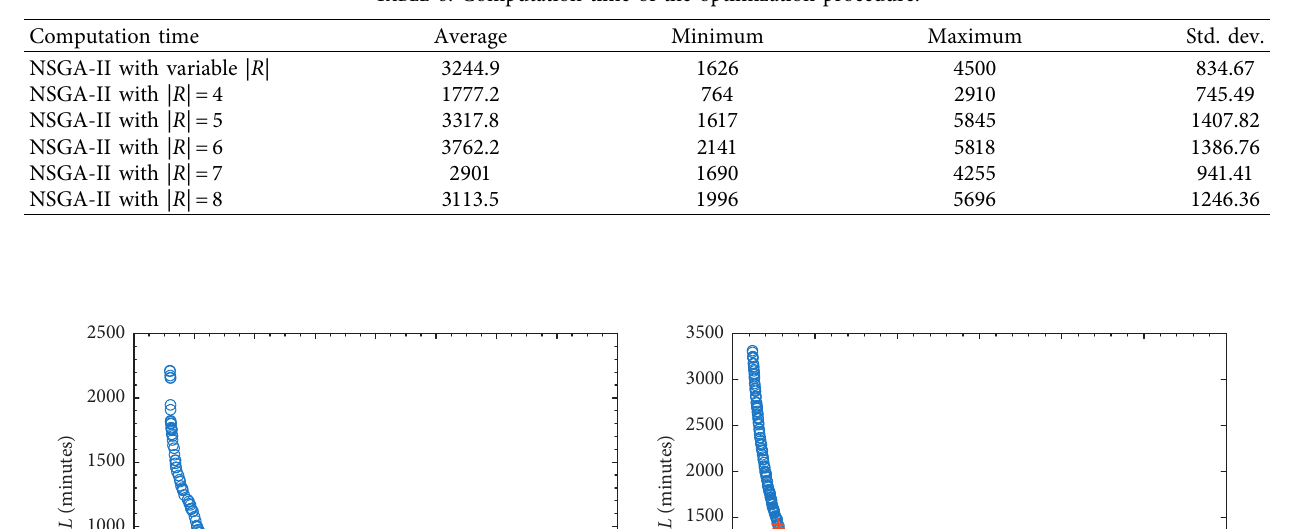
Table 6: Computation time of the optimization procedure.